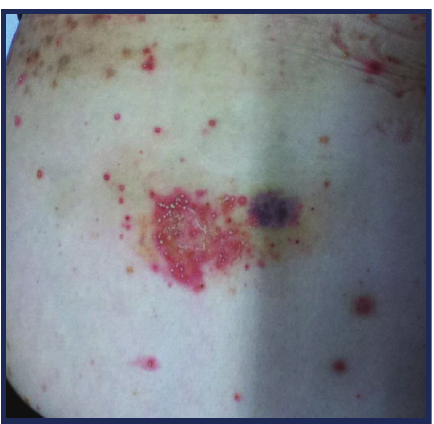
Figure 1: AGEP TCZ related lesions in reported patient with refrac- tory